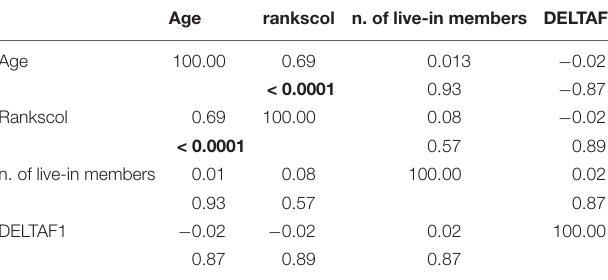
TABLE 4 | Spearman correlation matrix and p values between deltaf1 and demographic variables.